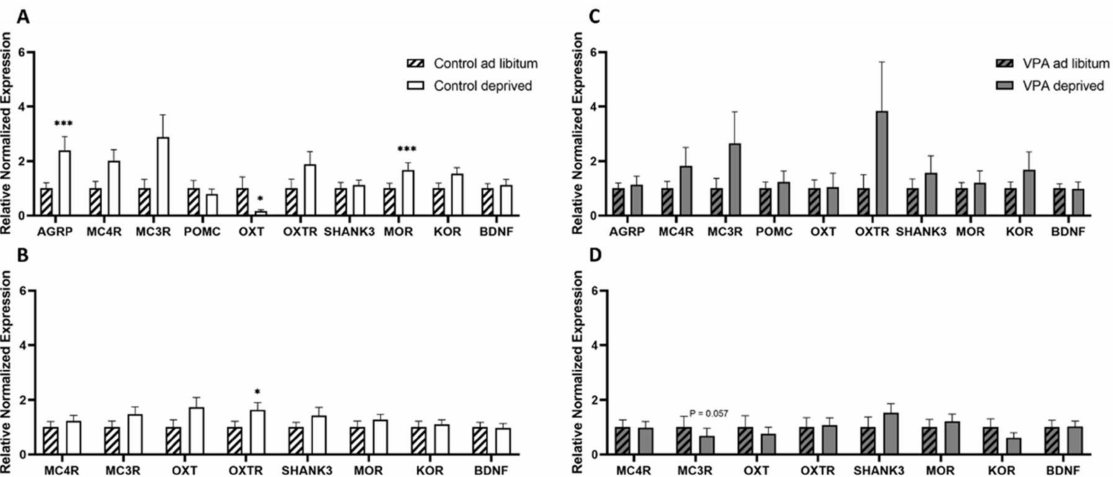
Figure 10. Differential gene expression patterns ( A ) in the hypothalamus of ad libitum-fed and food- deprived healthy control animals, ( B ) in the brainstem of ad libitum-fed and food-deprived healthy control animals, ( C ) in the hypothalamus of ad libitum-fed and food-deprived VPA animals and ( D ) in the brainstem of ad libitum-fed and food-deprived VPA animals. AgRP—agouti related protein, MC4R—melanocortin 4 receptor, MC3R—melanocortin 3 receptor, POMC—pro-opiomelanocortin, OXT—oxytocin, OXTR—oxytocin receptor, Shank3—SH3 And Multiple Ankyrin Repeat Domains 3, MOR—mu-opioid receptor, KOR—kappa-opioid receptor, BDNF—brain-derived neurotrophic factor. Data are expressed as mean ± SEM, n = 9–10/group. * p < 0.05, p < 0.01, *** p <